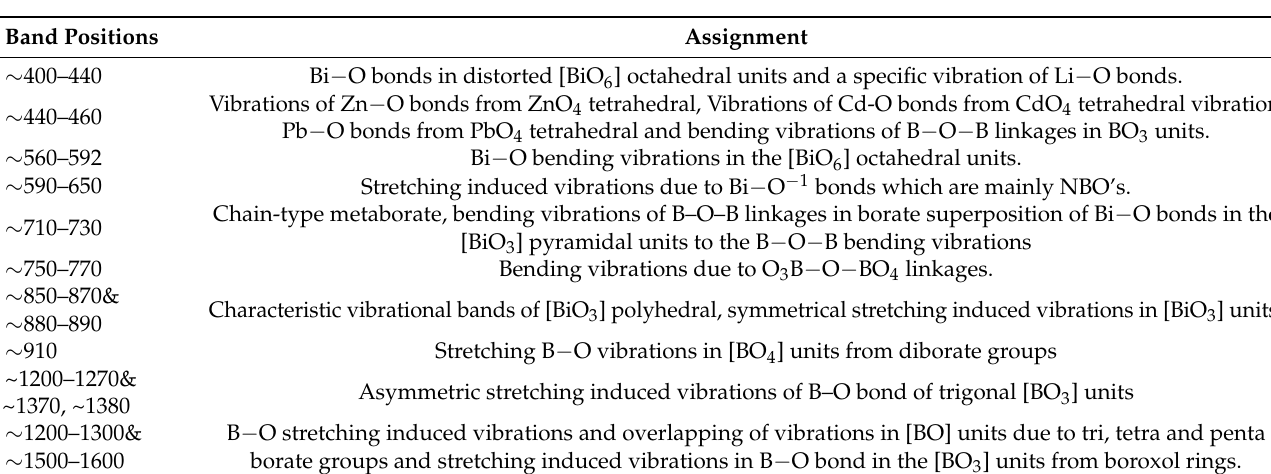
Figure 4. FTIR spectra of the BiBLM glasses. Table 3. Assignment of FT-IR bands of BiBLM